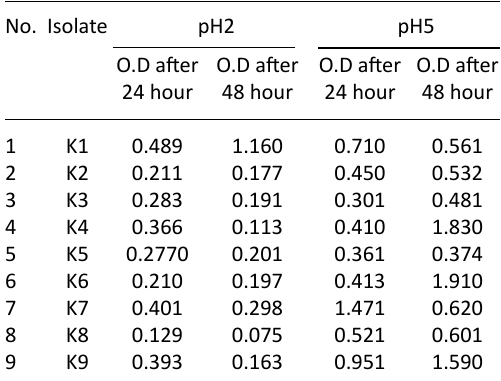
Table 5. Evaluation of Co-aggregation ability of isolates with test indicators Isolates E. S. P. Mean